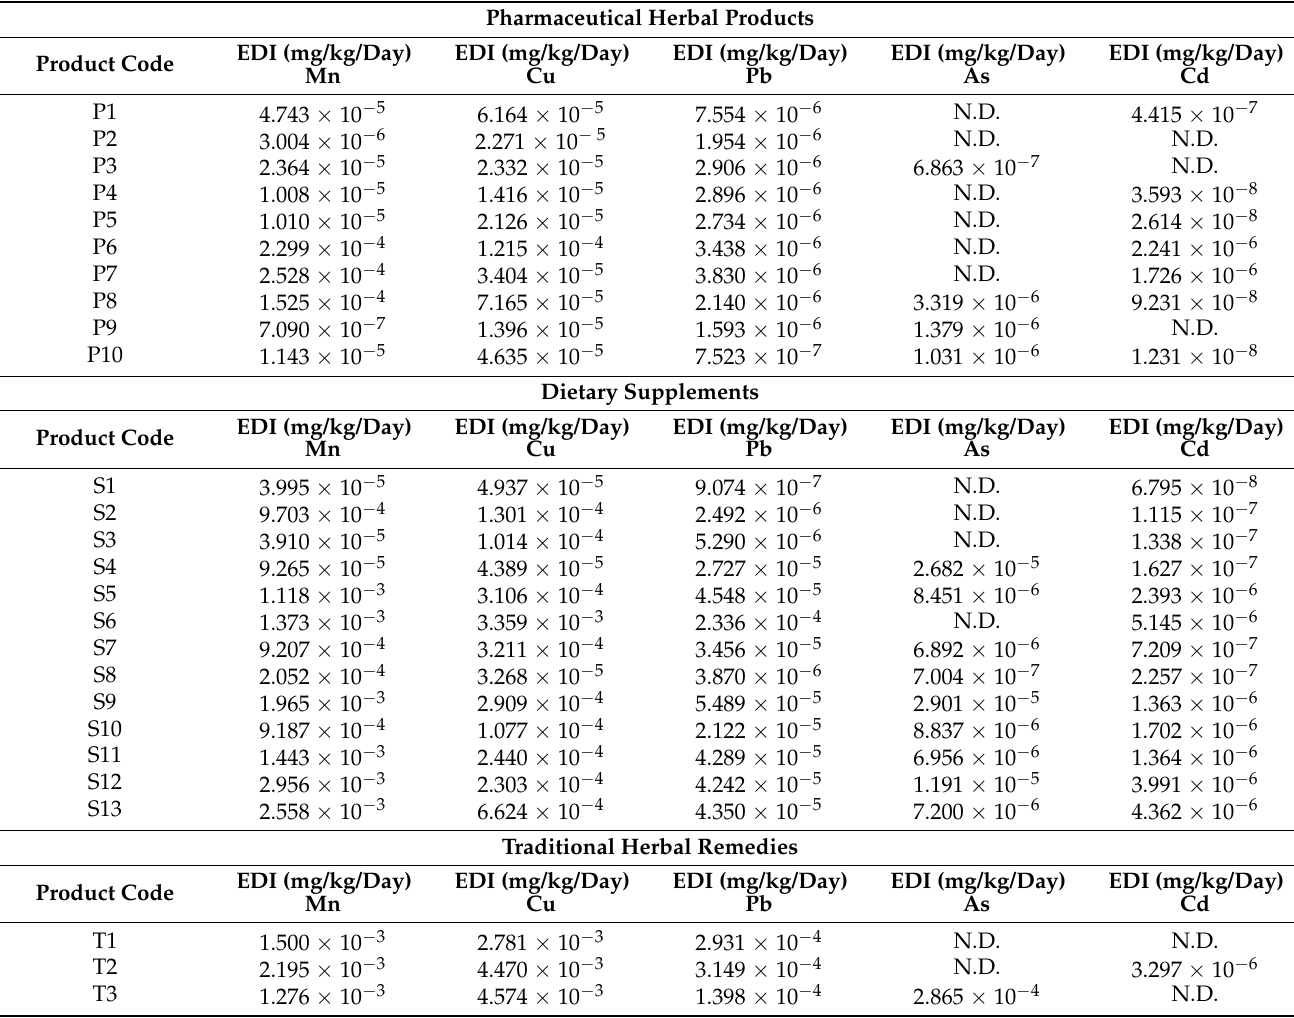
Table 4. Estimated daily intake (mg/kg per day) of different metals in pharmaceutical herbal products, dietary supplements, and traditional herbal remedies containing Ginkgo biloba . Pharmaceutical Herbal